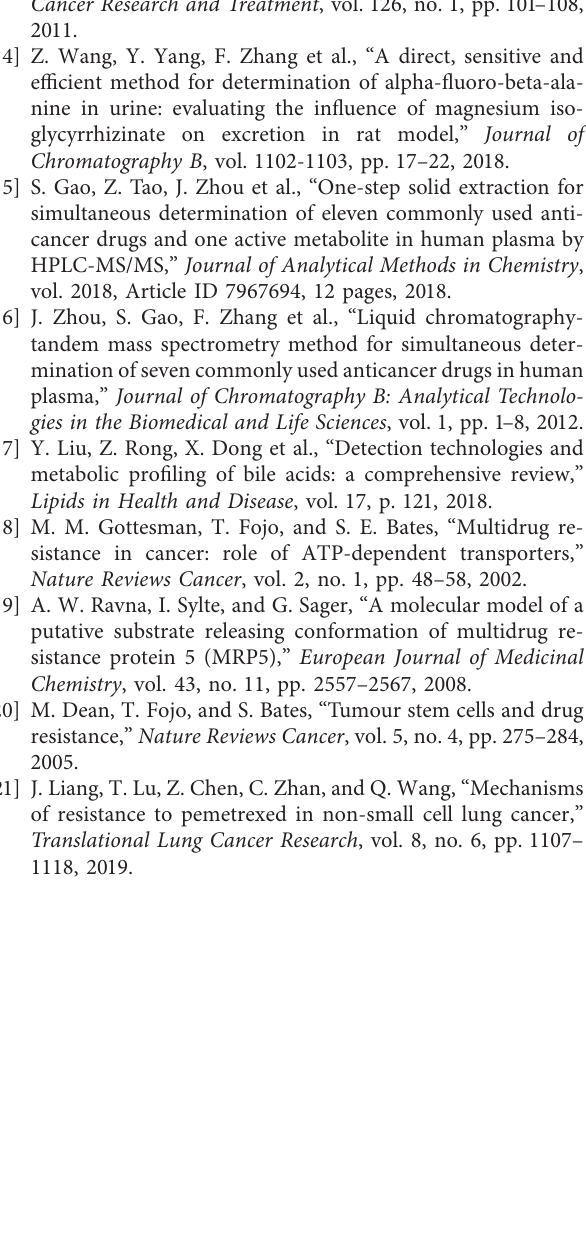
pemetrexed; (d) real sample. Table 1: linearity regression parameters of pemetrexed. Figure 2: comparative chro- matograms of carryover of pemetrexed. (a) Highest cali- bration standard sample and (b) blank sample. Table 2: interprecision and intraprecision and accuracy of peme- trexed ( n � 5). Table 3: recovery and matrix effect of pemetrexed (%). Table 4: results of stability investigation of pemetrexed. ( Supplementary Materials